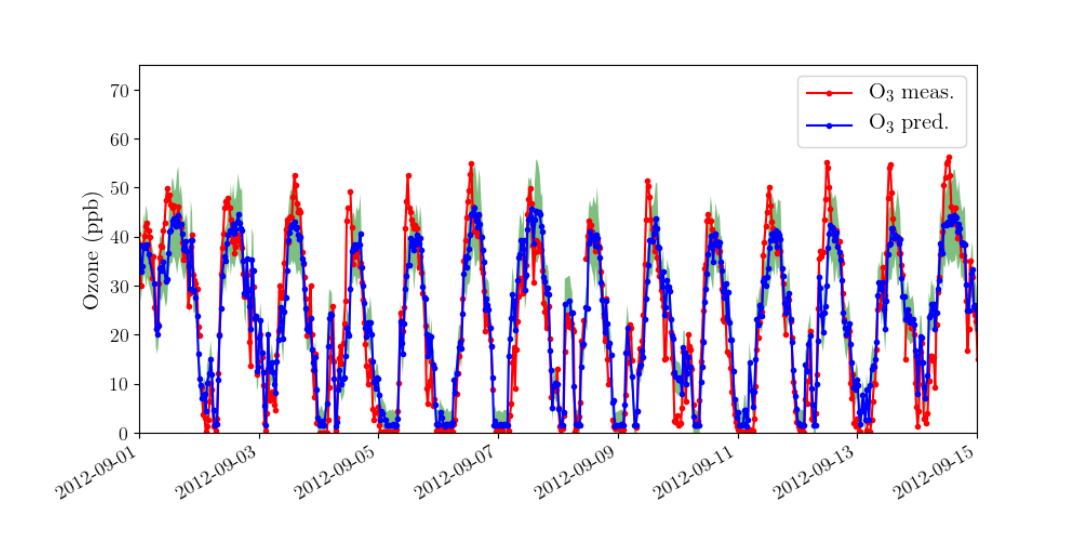
Figure 9. The time series data of real O 3 measurement (red), the O 3 estimation (blue) produced by the BNN and its confidence interval (light